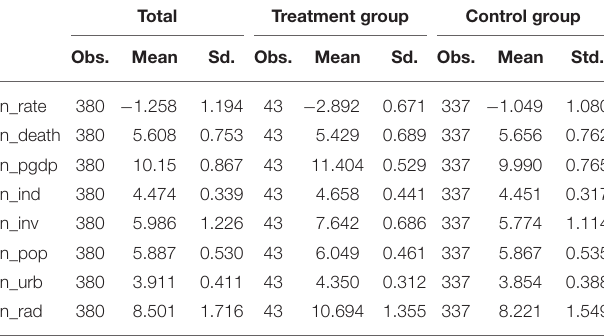
TABLE 2 | Descriptive statistics of key variables.